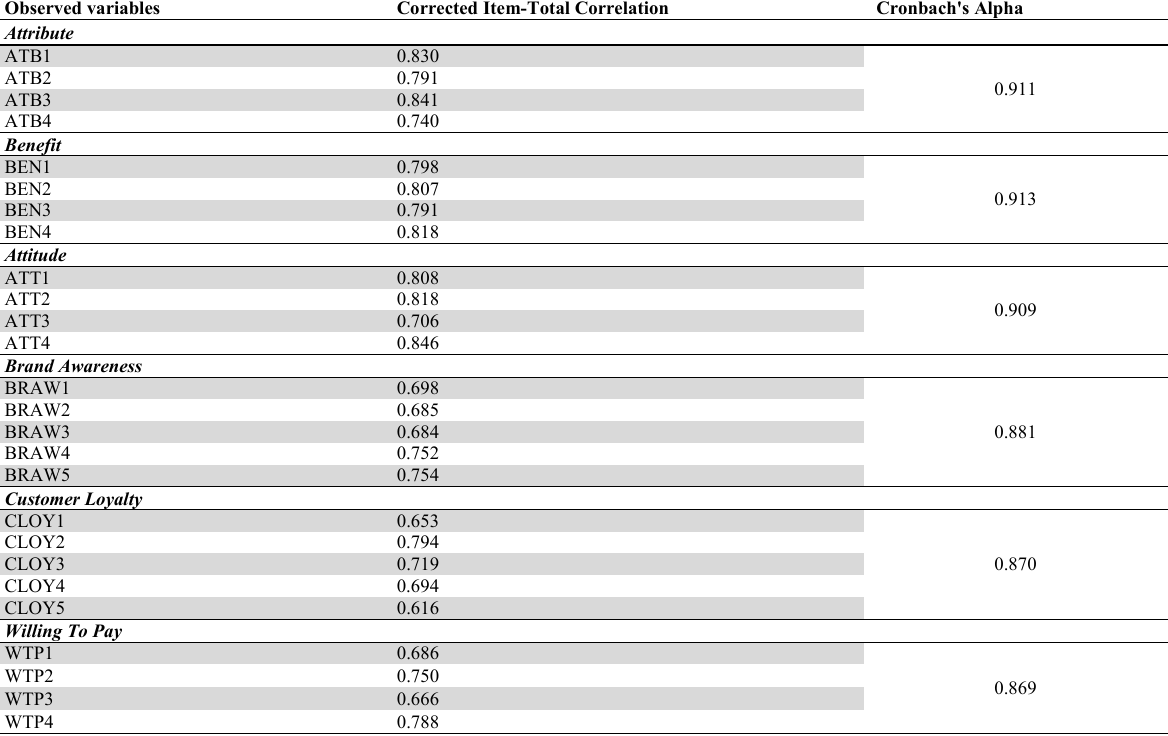
Cronbach’s coefficient and Corrected Item-Total Correlation Observed variables Corrected Item-Total